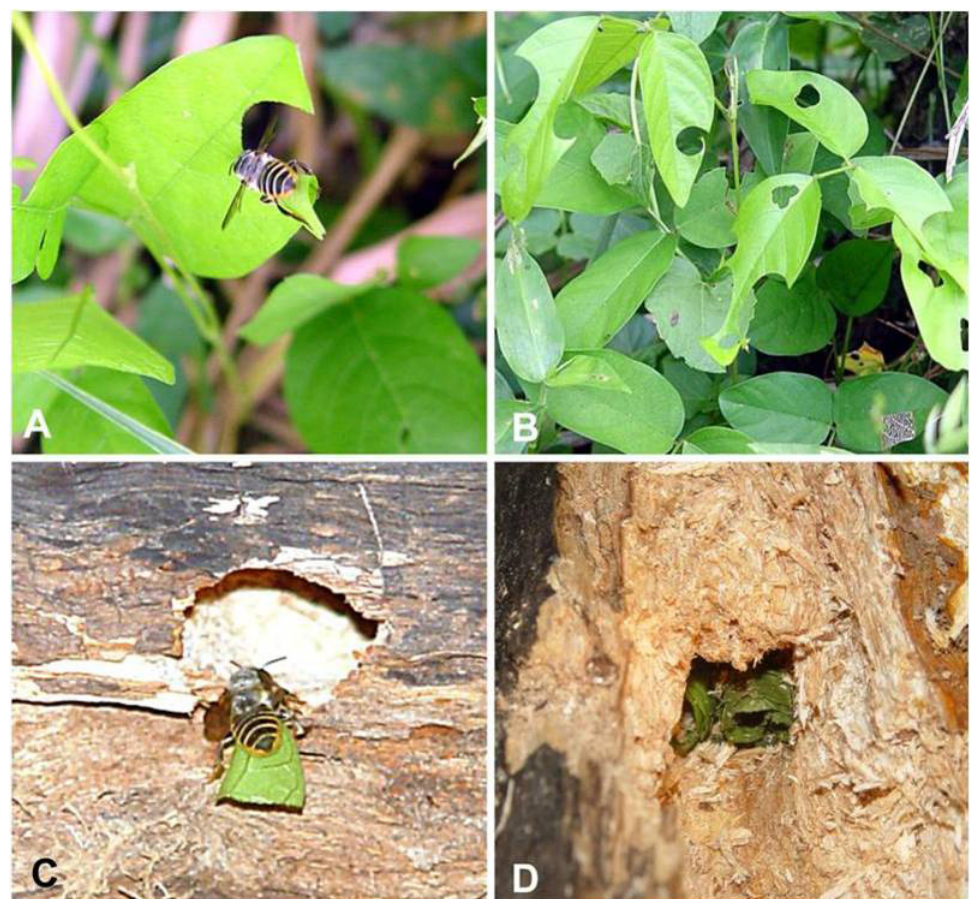
Fig 1 . Nest building by females of Megachile apicipennis . (a) Female of Megachile apicipennis cutting a piece of a leaf of Centrosema virginianum , (b) specimen of Centrosema virginianum (four meter distant from the nest) showing damage to leaves done by leafcutting bees, (c) female of Megachile apicipennis entering the nest with a leaf piece of Centrosema virginianum , and (d) three cell series of Megachile apicipennis located at the end of the abandoned gallery of Xylocopa frontalis